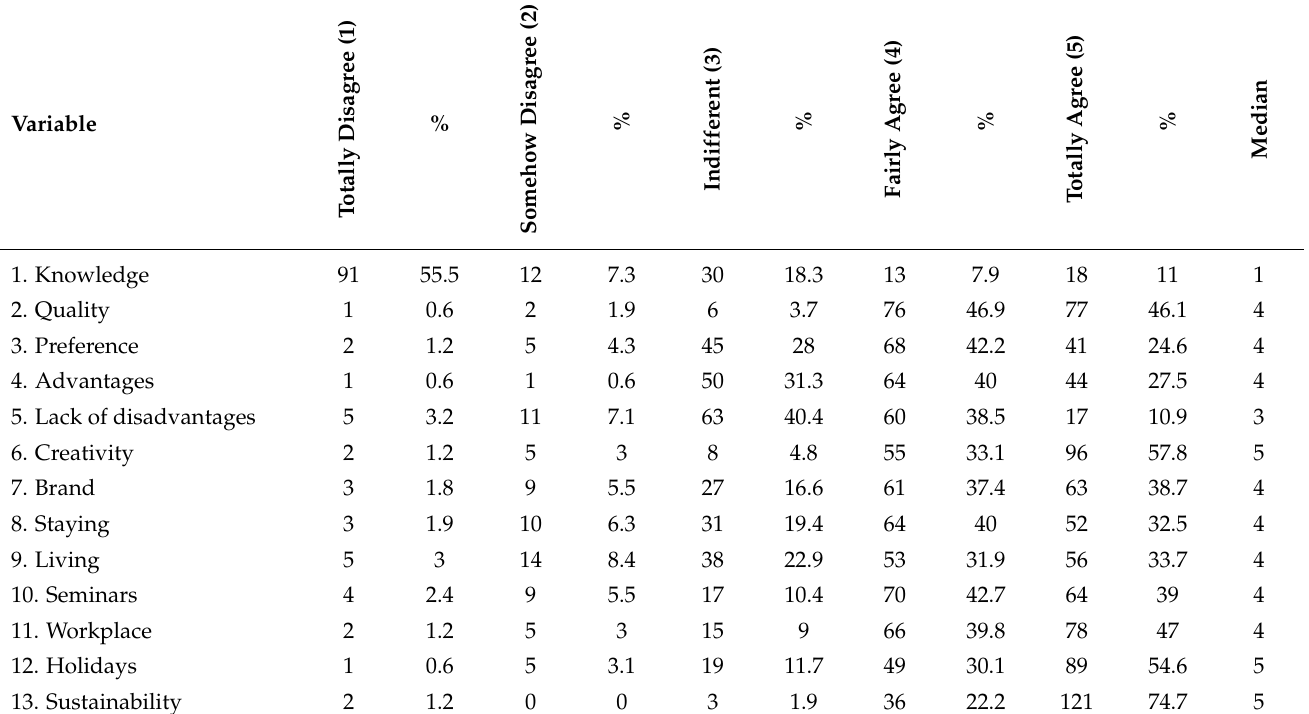
Table 3. Number of answers for each variable of the perception questionnaire reported along with percentages and